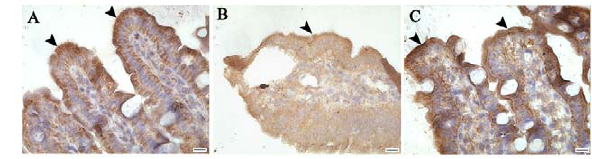
Figure 7. Changes in ZO-1 expression in acute intestinal I/R mice after KGF treatment by immunohistochemistry. ZO-1 expression was detected in the sham group (A), at 6 h after I/R (B) and after KGF treatment (C). KGF maintained the intense apical staining for ZO-1 at 6 h after I/R when compared with the I/R (6 h) group. Arrow, ZO-1 expression. Original magnification: 6 630, n=6 per group. Scale bar=25 m m.